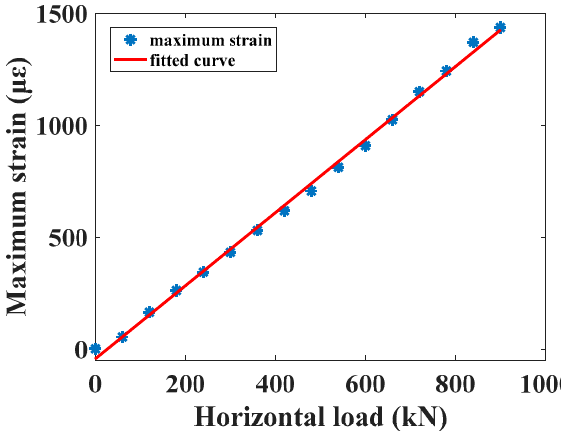
Figure 7. Load and maximum strain ( F- ε max ) curve at − 19.63 m.